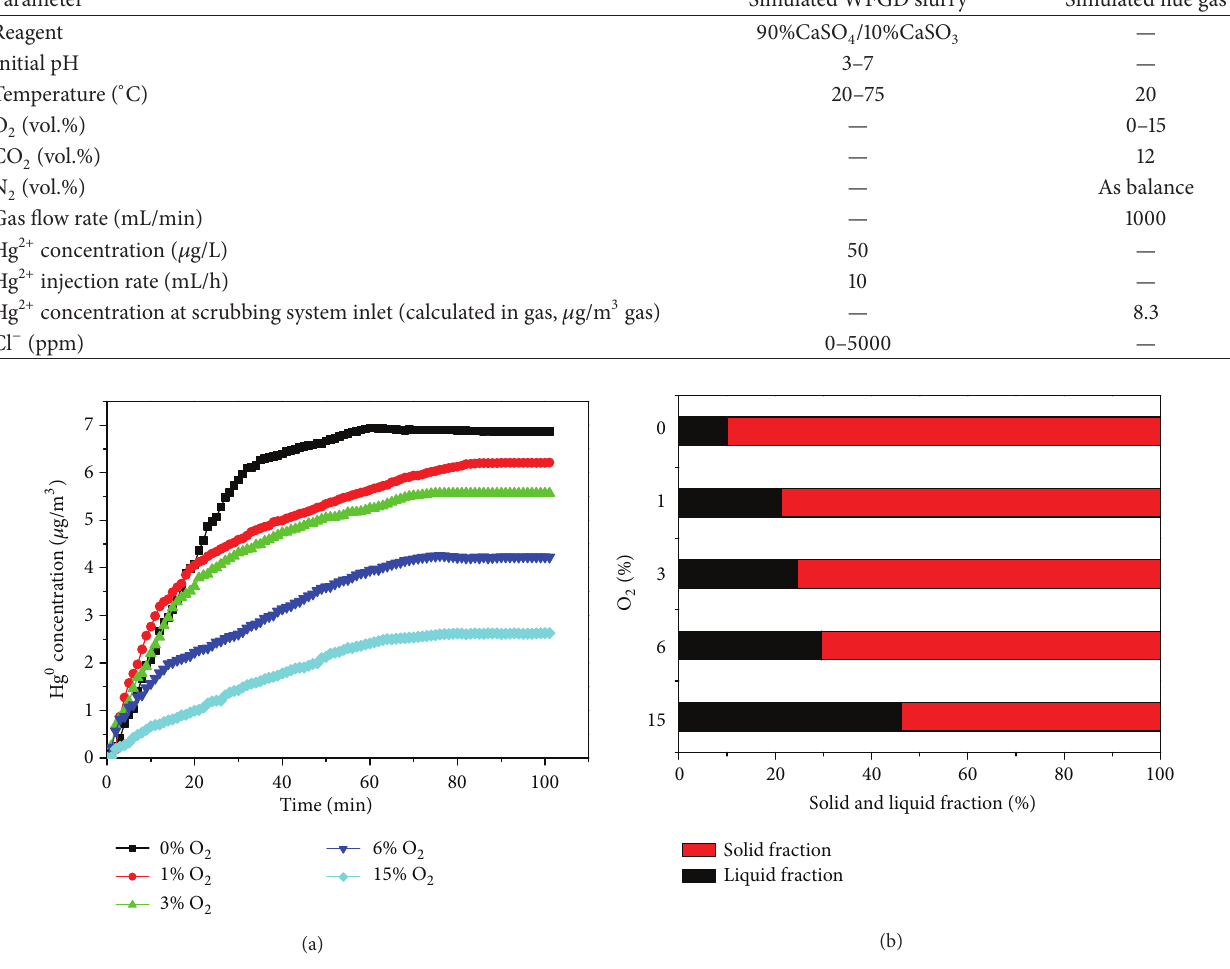
Figure 2: (a) Effect of the oxygen concentration in the flue gas on Hg 0 reemission. (b) Relationship between the proportion of mercury retained in the solid and liquid fraction of the slurry and the concentration of oxygen concentration in the flue